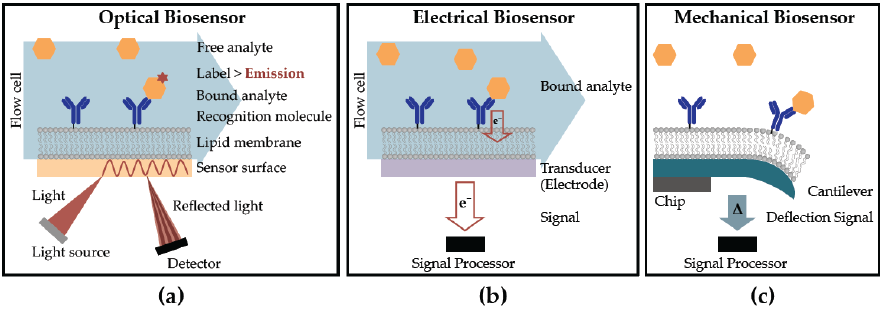
Figure 1. Examples of biosensor techniques incorporating lipids for the detection of analytes include ( a ) optical ( b ) electrical and ( c ) mechanical.